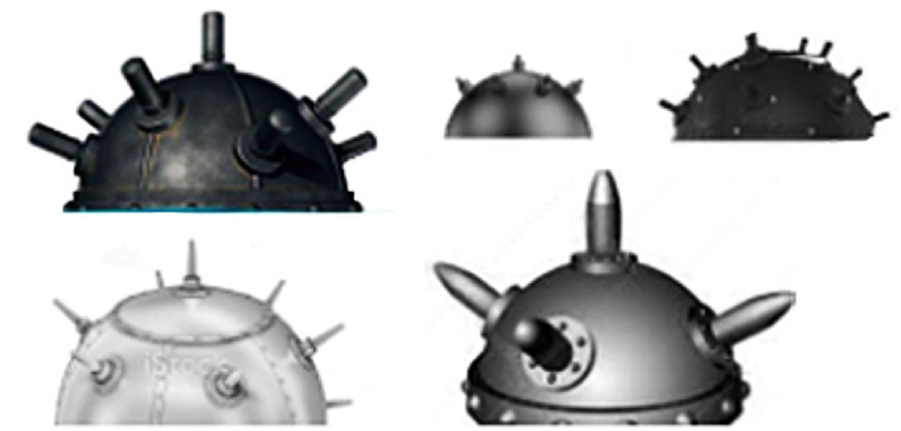
Figure 7. Mine Images.